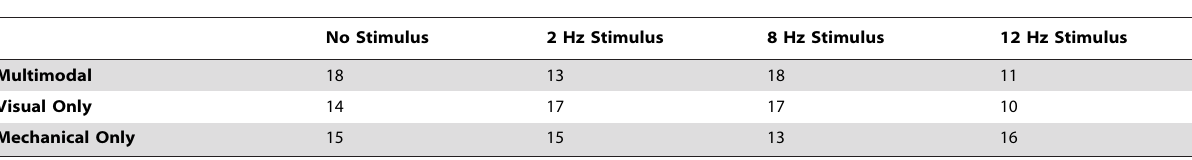
Table 1. Sample sizes for different experimental